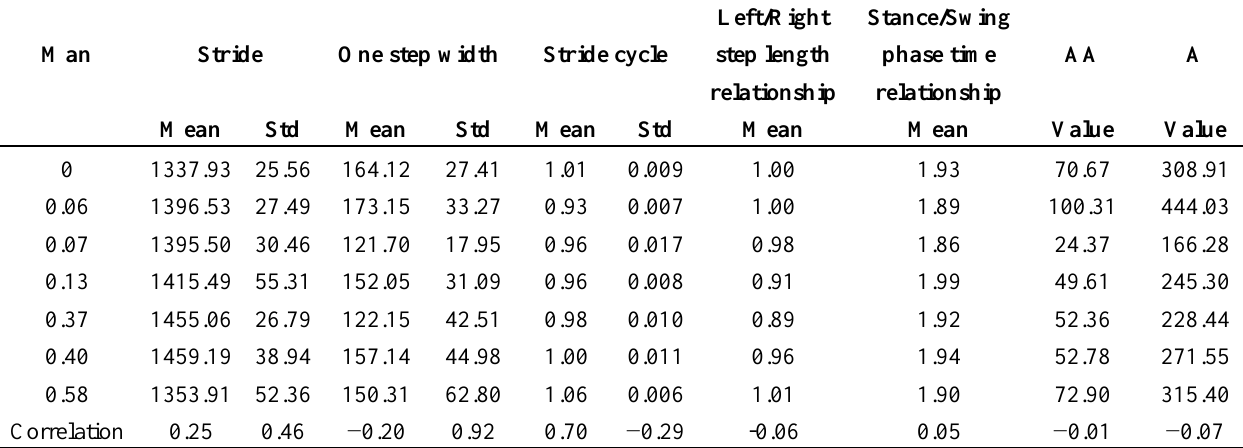
Table 6. Gait parameters relative to alcohol intake: Man